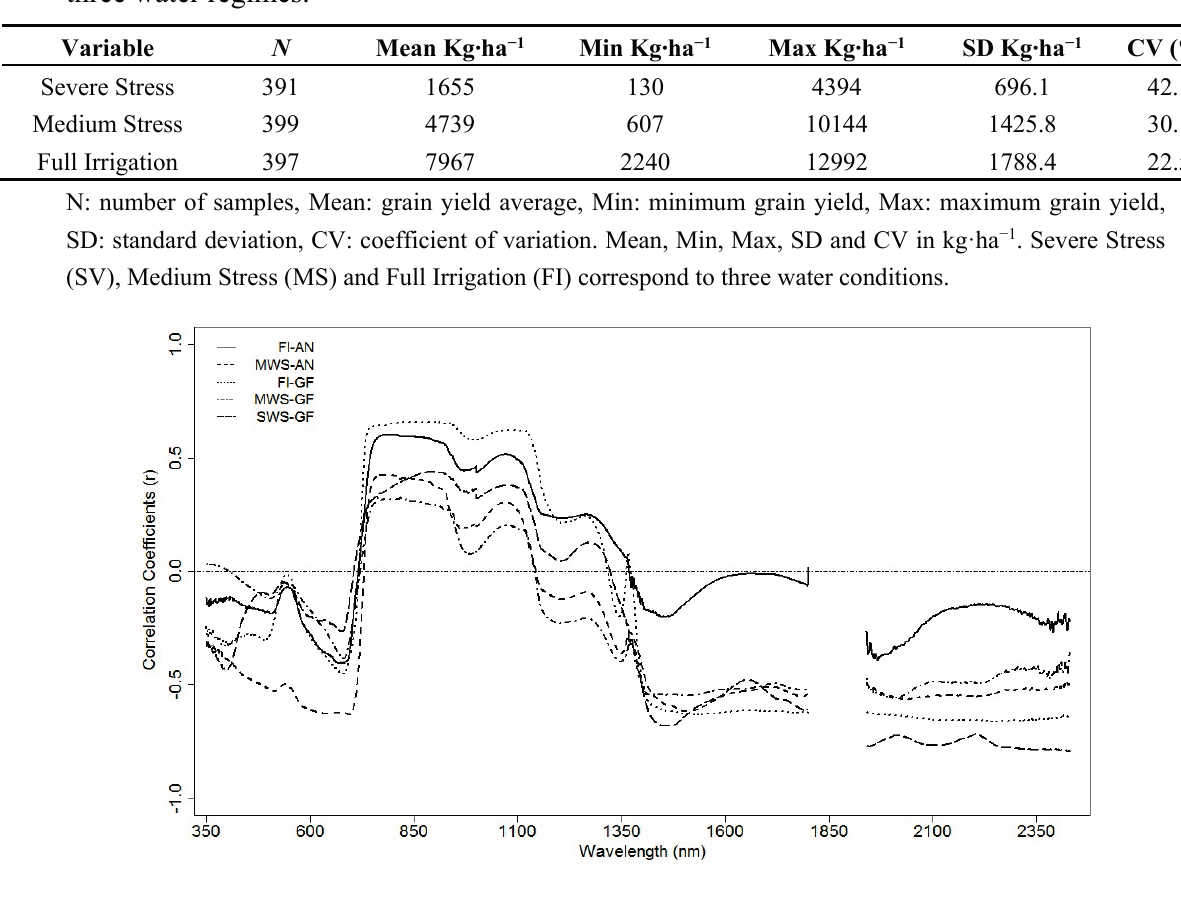
Figure 1. Pearson’s coefficient of correlation (R) between grain yield and wavelengths measured at anthesis (AN) and grain filling (GF) under severe water stress (SWS), medium water stress (MWS) and full irrigation